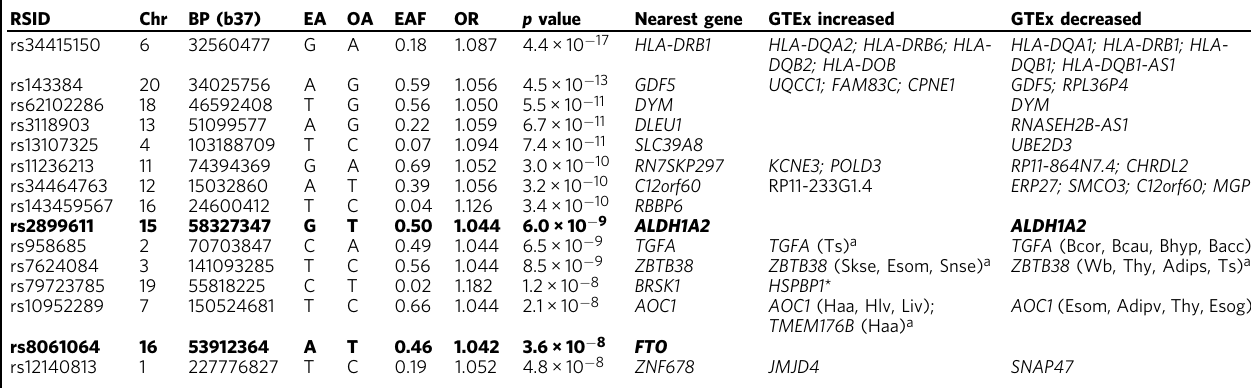
Table 1 Fifteen genomic risk loci associated with low grip strength in 256,523 older men and women.